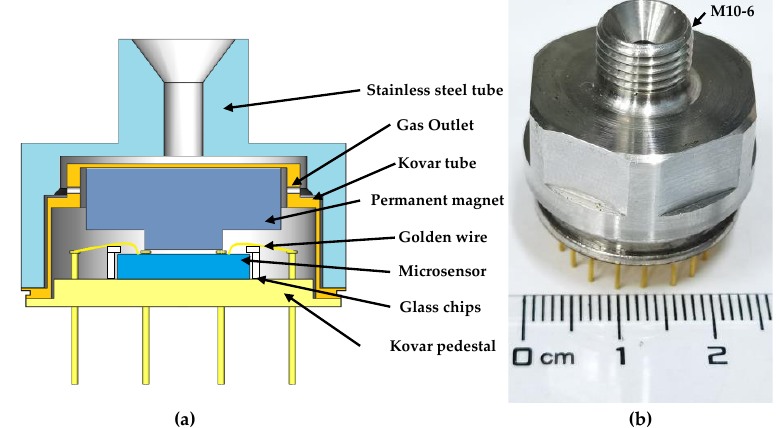
Figure 7. ( a ) The cross-section image of the resonant pressure sensor’s packaging concept; ( b ) an image of the packaged microsensor.